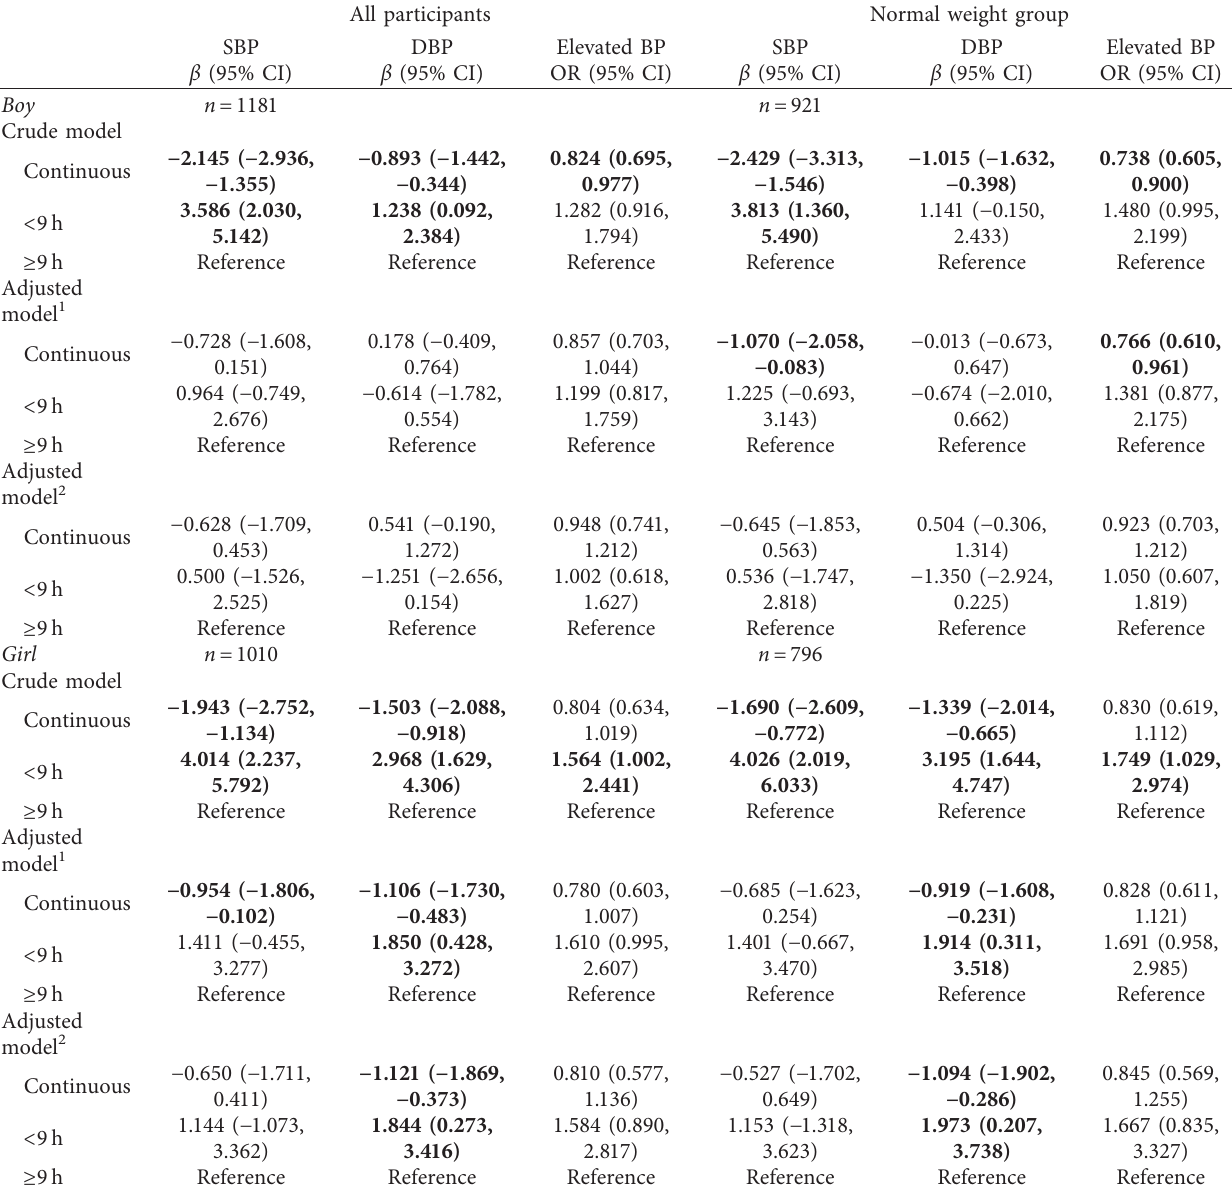
Table 4: The association of sleep duration with SBP, DBP, and elevated BP stratified by gender in 2004–2015. All